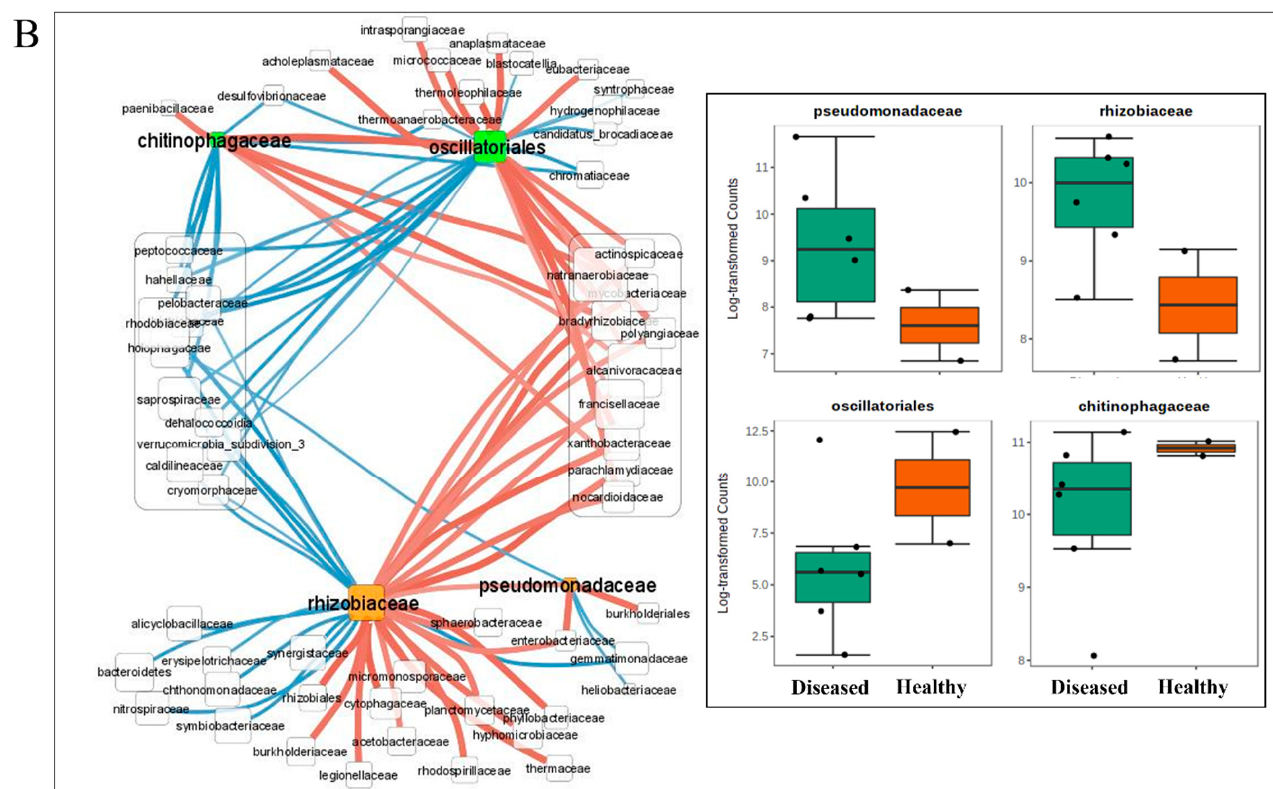
Figure 7. Inference of taxa associations in the healthy and TRD soybean root biomes. ( A , B ) Correlation networks based on Pearson correlation of ITS ( A ) and 16S ( B ) rRNA reads extracted from metagenomes of healthy and TRD symptomatic plants with nodes representing taxa and edges representing correlations between taxa pairs. A connection between nodes stands for a statistically significant ( p < 0.05) correlation. Node size is proportional to reads abundance. Blue edges show a negative correlation, whereas red shows positive correlations. Box plots of taxa showing a differential abundance in TRD versus healthy controls to the right.